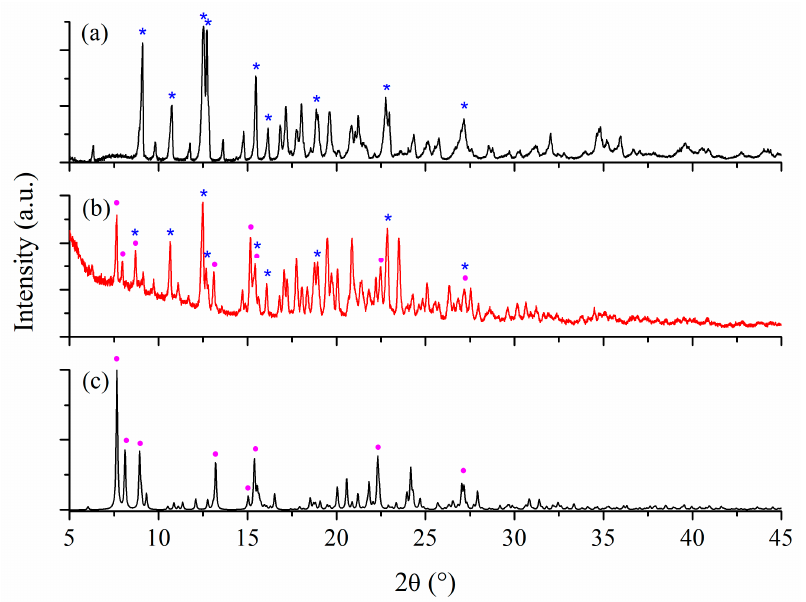
Figure 5. Powder X-ray diffractograms for β -CD (peaks marked with *) ( a ), ( 2a )@ β -CD ( b ), and simulated from single crystal X-ray analysis for ( 2 ) (peaks marked with • ) ( c ).